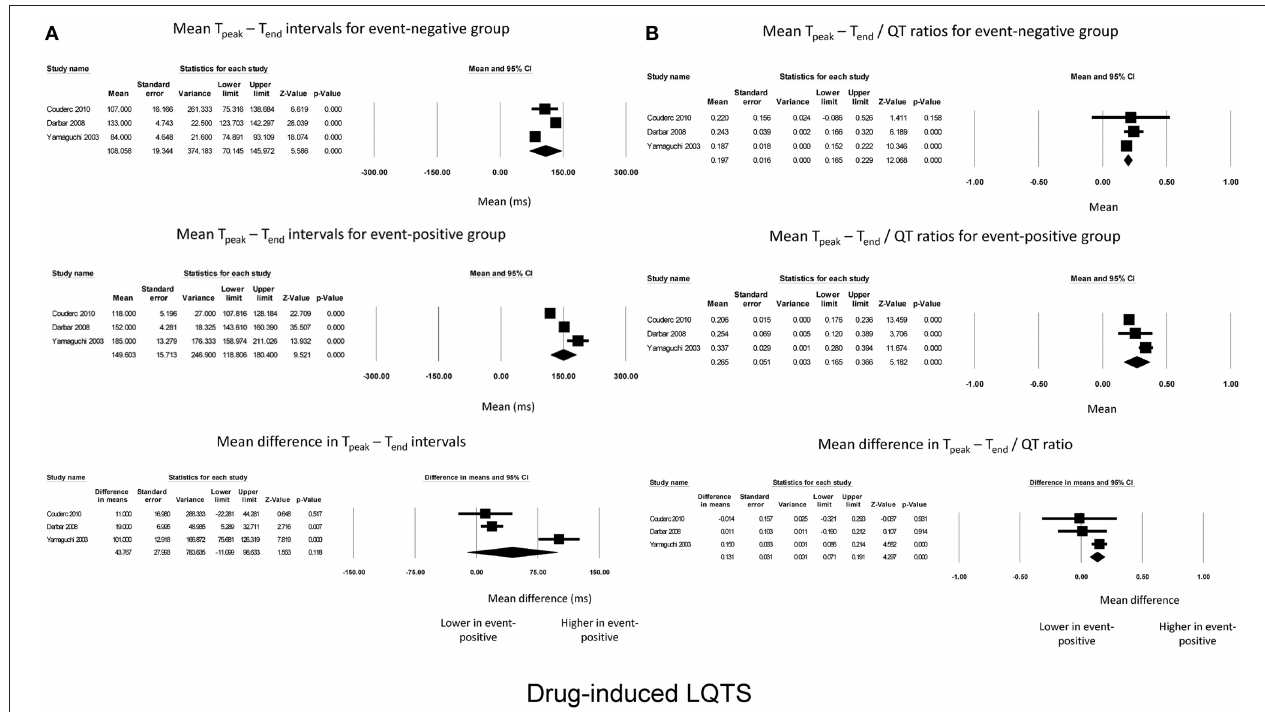
FIGURE 2 | Forest plot demonstrating the (A) mean T peak – T end intervals in the event-negative group (top panel), event-positive group (middle panel) and difference between both groups (bottom panel) in acquired QT prolongation, and (B) mean T peak – T end /QT ratios in the event-negative group (top panel), event-positive group (middle panel) and difference between both groups (bottom panel) in drug-induced QT